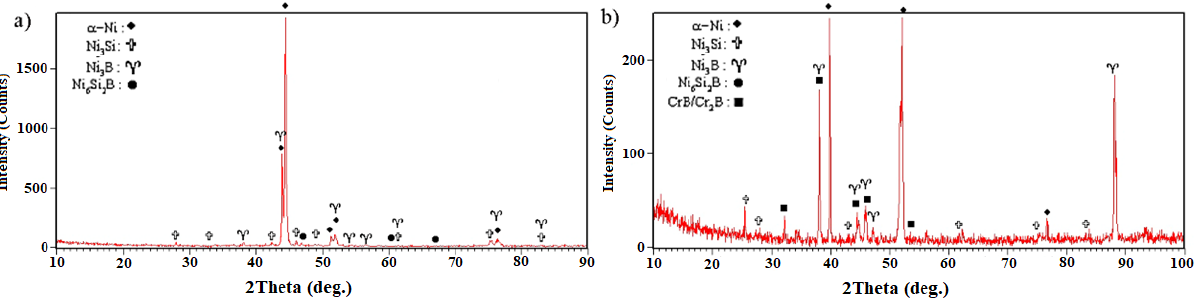
Figure 15. XRD patterns of fracture surfaces with different conditions: ( a ) 1010 °C/10 min and ( b ) 1050 °C/10 min.